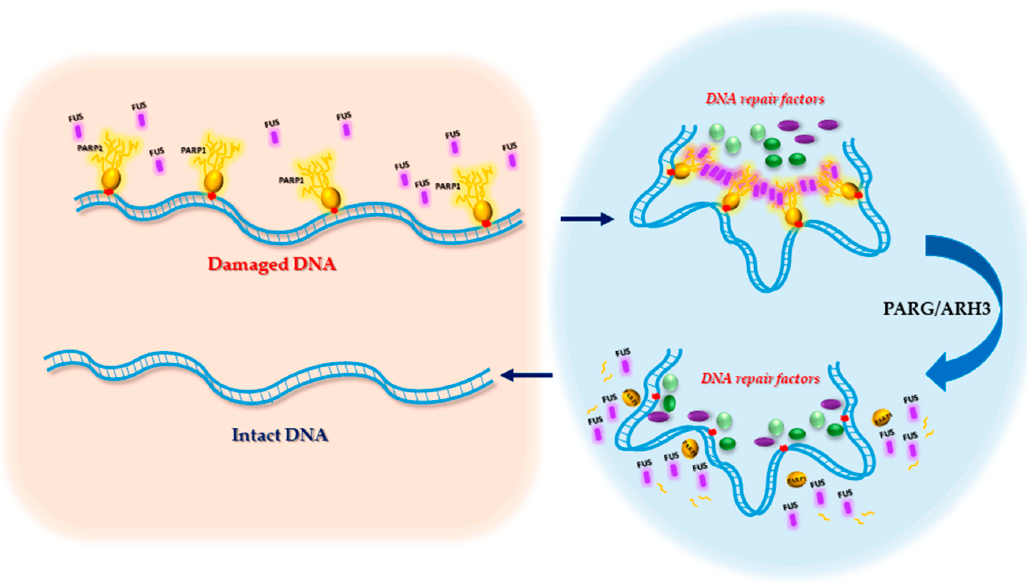
Figure 7. Creation of a repair compartment driven by the interaction of FUS with PAR. The compartment is a cluster of PARylated PARP1 bound by FUS that is concentrated to create a genomic region that is active in terms of DNA repair and may concentrate damaged DNA with subsequent recruitment of DNA repair proteins. PARG dissociates damaged DNA compartments by hydrolyzing PAR.